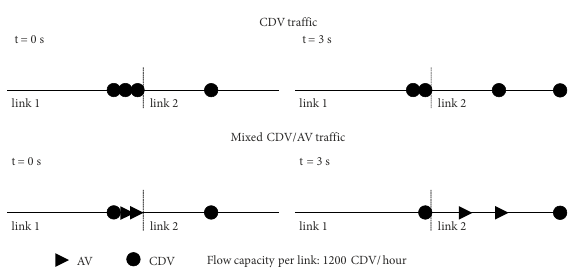
1.01.21.41.61.82.0